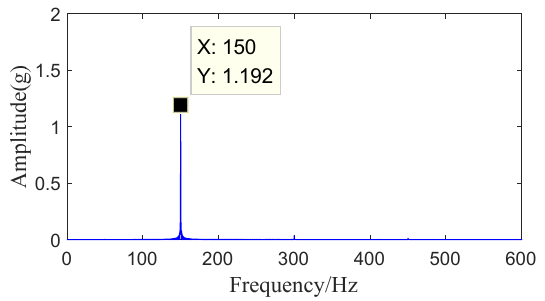
Figure 11. Vibration response of 304 stainless steel clamp with a 200- µ m-thick hard coating of 8% Y 2 O 3 -Z r O 2 under 150 Hz fixed-frequency excitation.